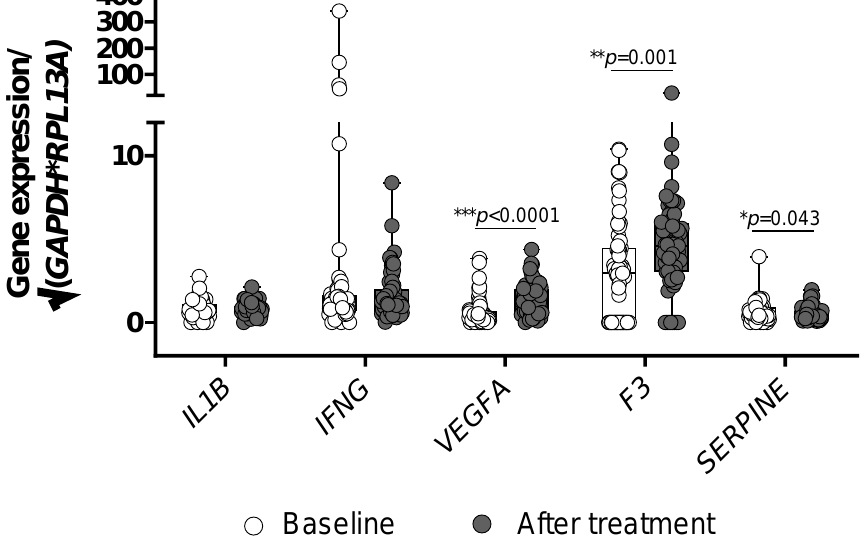
Figure 5. Comparison of the gene expression profile before and after treatment with PCSK9 inhibitors in patients with CAD. Significant differences were obtained for VEGFA , F3 and SERPINE as indicated (*** p < 0.0001, ** p < 0.001, * p < 0.05, Wilcoxon signed rank test). Shown are box and whisker plots with individual values. Gene expression data are normalized to geometric mean of glyceraldehyde-3-phosphate dehydrogenase ( GAPDH ) and ribosomal protein L13a ( RPL13A ).